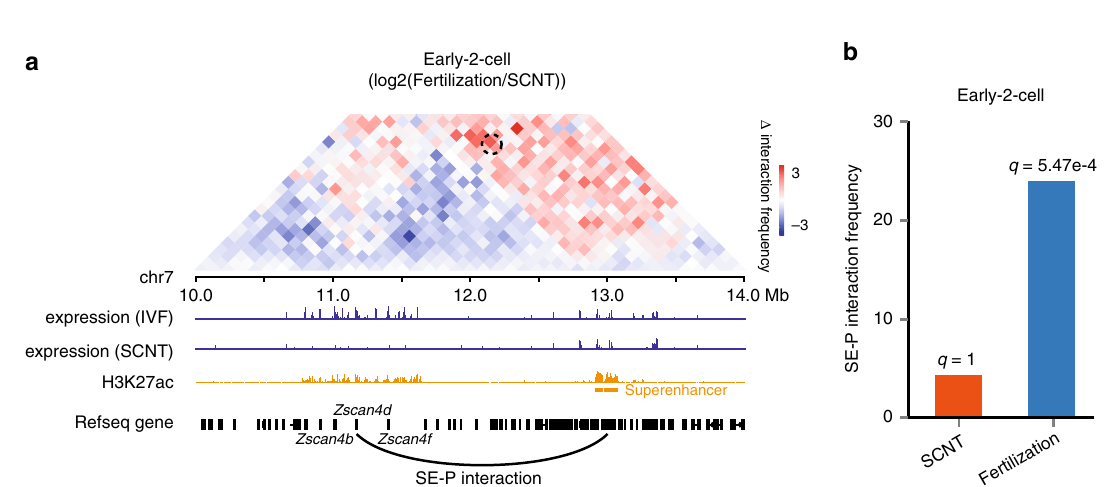
Fig. 5 Defects of promoter and super-enhancer interactions in SCNT embryos. a The top heatmap shows the differential interaction frequencies at the Zscan4d locus between fertilization-derived and SCNT early-2-cell embryos. The dashed circle indicates the SE – P interactions in fertilization-derived embryos but not in SCNT embryos. The bottom tracks show gene expression in IVF and SCNT embryos, H3K27ac signals in fertilization-derived 2-cell embryos, and Refseq genes, respectively. Source data and exact p-value are provided as a Source Data fi le. b The normalized interaction frequencies between the super-enhancer and promoter of Zscan4d . The q -values were calculated in Fit-Hi-C by applying Benjamini-Hochberg correction to the p -values, as computed by the binomial distribution model